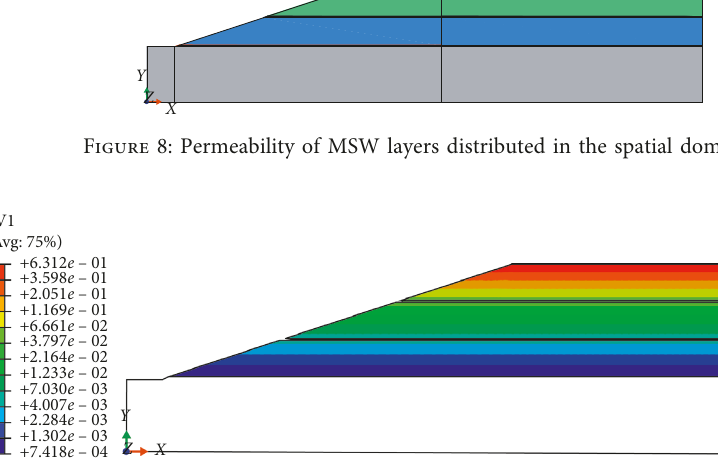
Figure 9: Permeability of MSW in a logarithmic distribution in the spatial domain